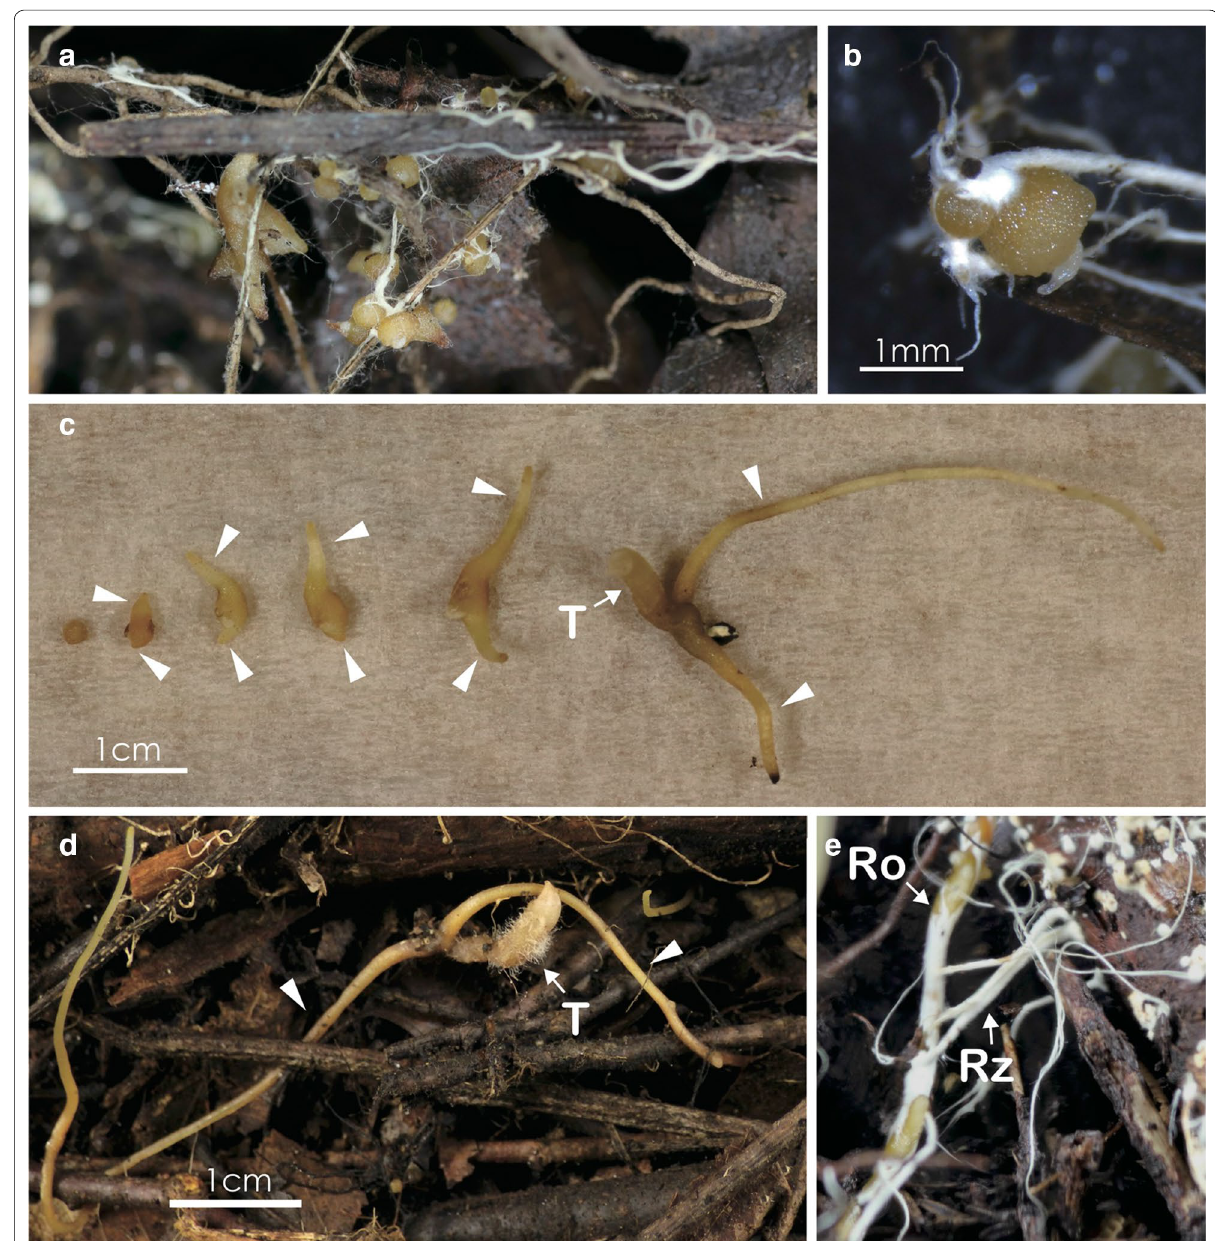
Fig. 2 Seed germination and seedling growth of Gastrodia pubilabiata . a , b Protocorms after 35 days of culture. Fungal hyphae and white rhizo‑ morphs are evident around the protocorms; c Seedlings after 35 days of culture. Roots (arrows) and tubers (T) are evident; d A Box 1 seedling after 65 days of culture. Elongated roots (arrows) and hairy tubers (T); e A seedling root with attached fungal rhizomorphs after 120 days of culture. Rhizomorphs (Rz) growing from a dead branch are connected to a mycorrhizal root